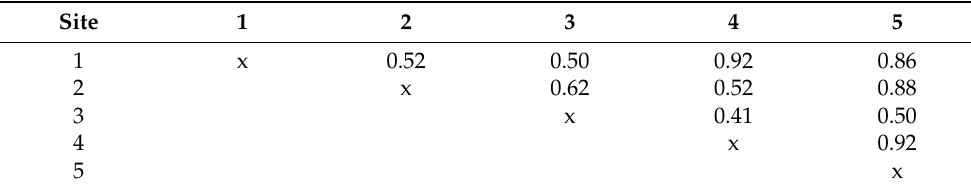
Table 3. The species similarity index between sites in